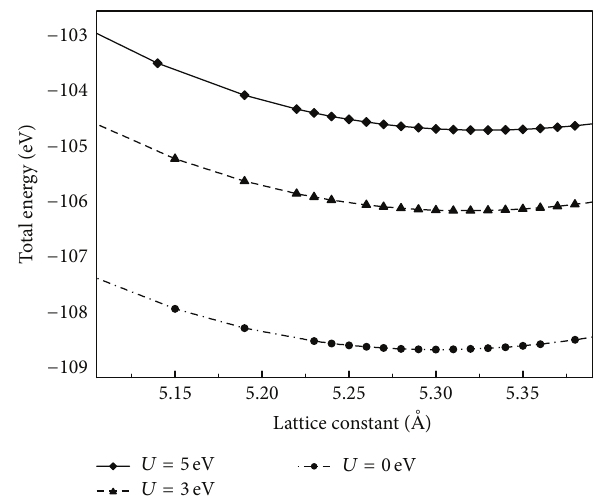
Figure 1: The equilibrium lattice constant of CeSZ calculated using the GGA and GGA + 𝑈 .